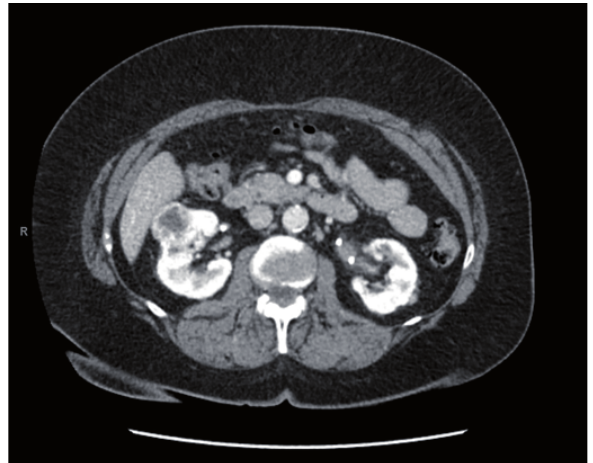
Figure 4 - Preoperative TC sCAn image.